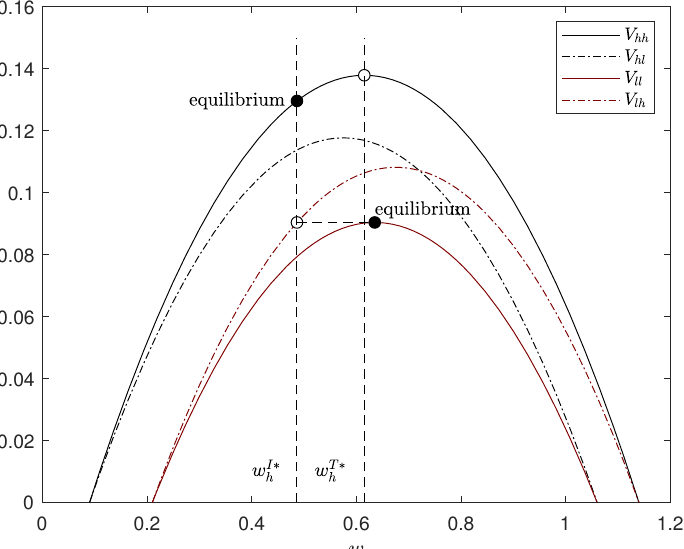
Figure 1. Demonstration of separating equilibrium. The parameters are: t = 1, p c = 0.3, µ = 0.5, G = 0, a = 1, b = 0.2, e h = 0.7 and e l =